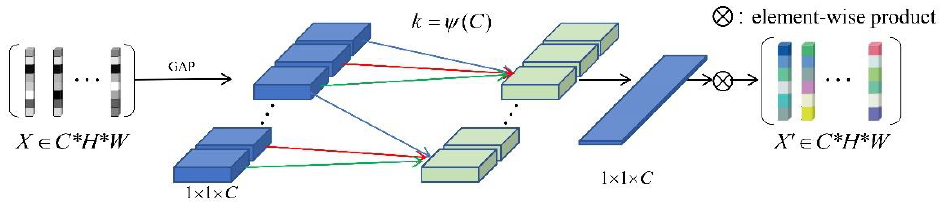
Figure 3. ECA (Efficient Channel Attention) module structure.